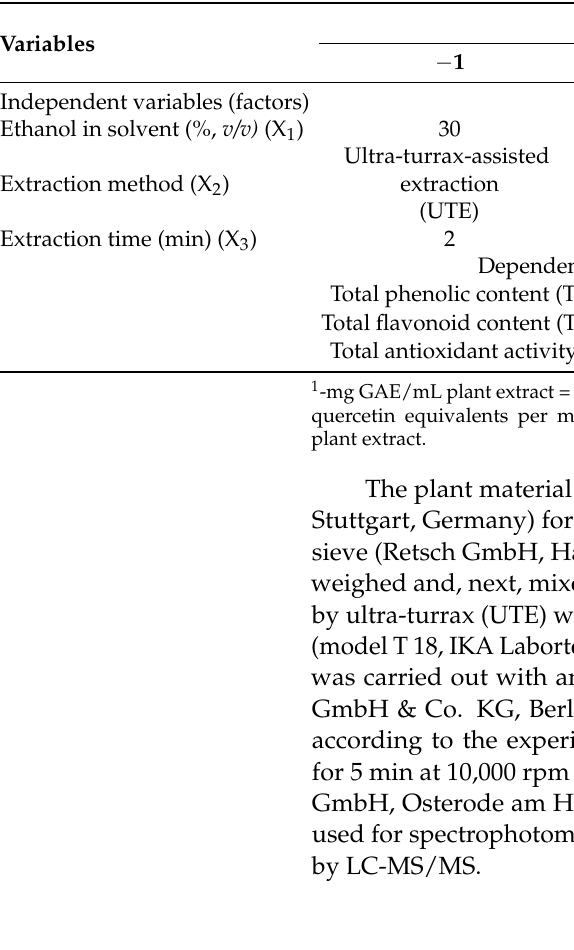
Table 2. Independent and dependent variables of the experimental design applied to find the optimum extraction conditions for Epilobium species